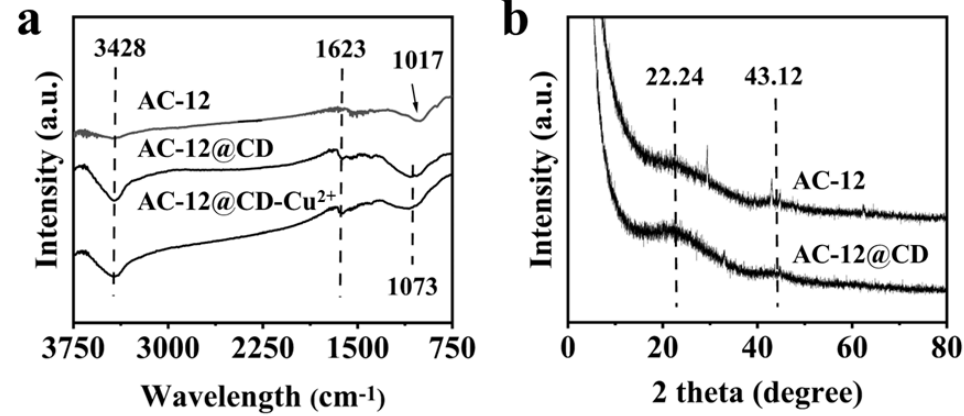
Figure 4. ( a ) FT − IR spectra of AC-12 and AC-12@CD, ( b ) XRD diffraction of AC-12 and AC-12@CD.